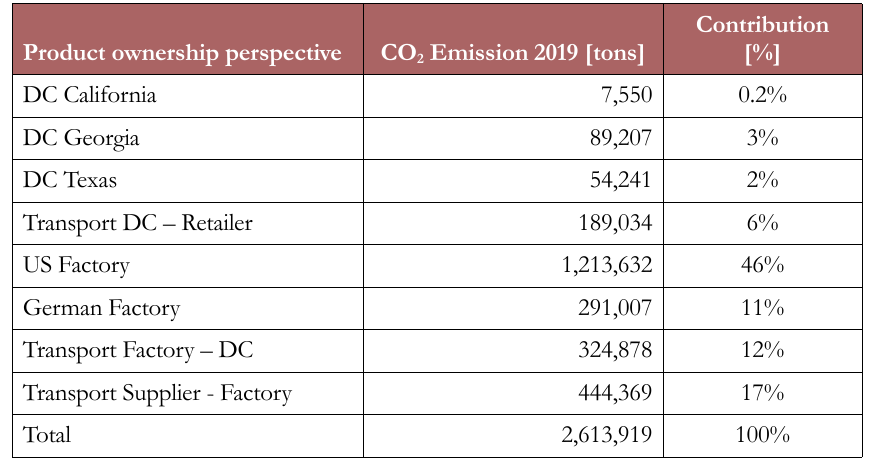
Table 3. Carbon emissions divided according to the product ownership